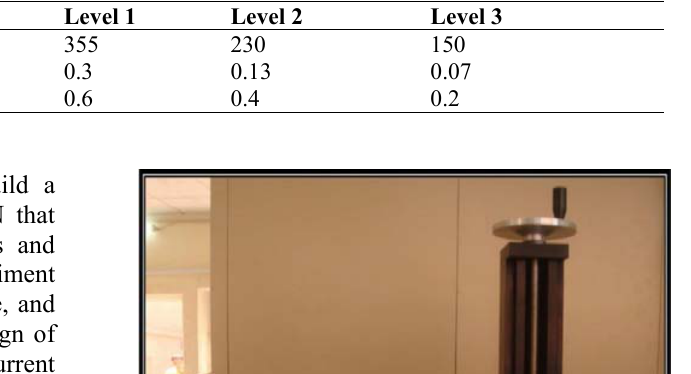
Fig. 1. Turning process in experimental work. Table 1, Control factors and levels